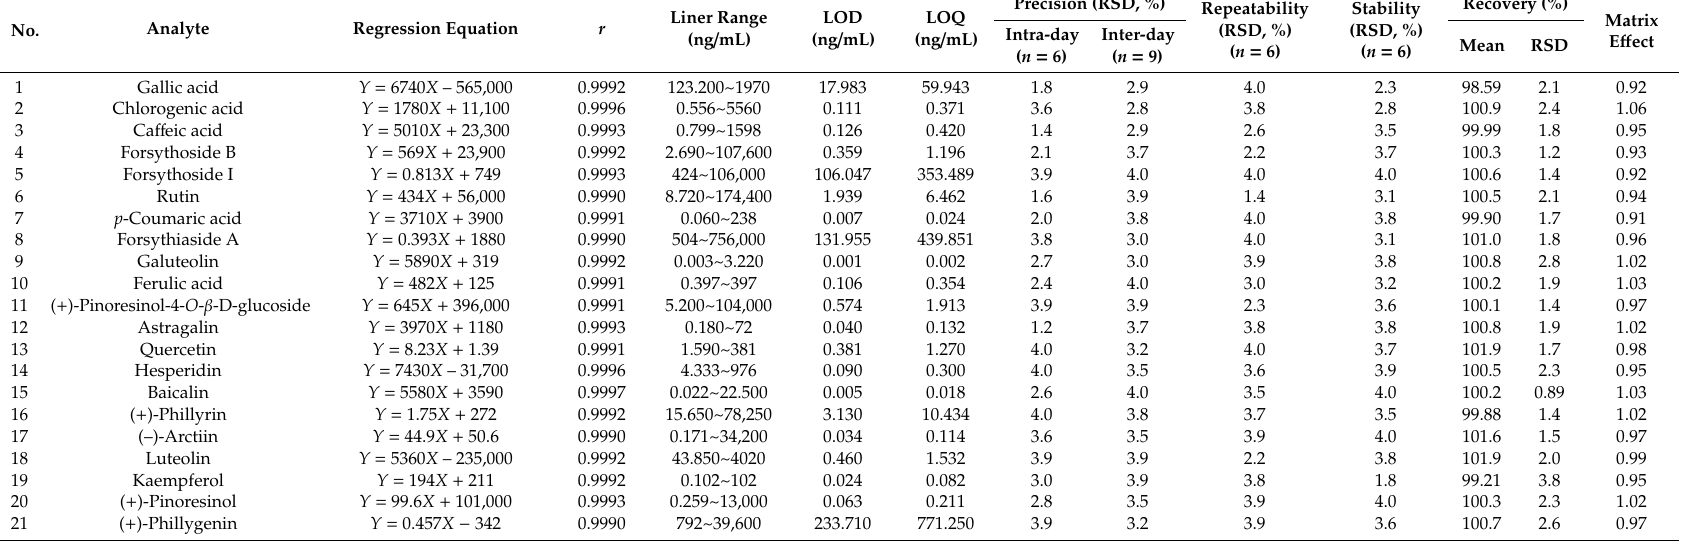
Table 2. Regression equations, limits of detection (LODs) and limits of quantification (LOQs), precision, repeatability, stability, recovery test, and matrix e ff ect of twenty-one